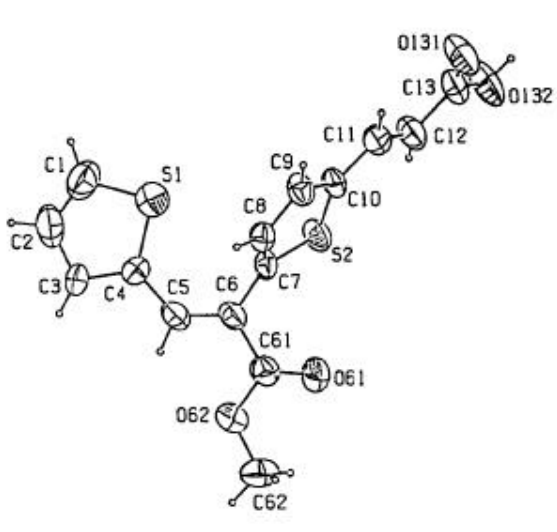
Figure 1. X-Ray structure of the 3-{5-[1-methoxycarbonyl-2-(2- thienyl)ethenyl]-2-thienyl}acrylic acid ( 5 )